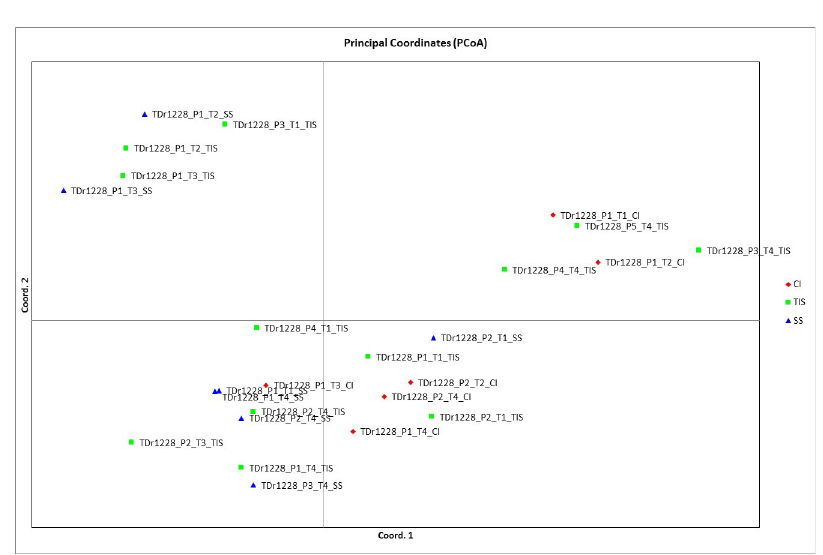
Fig 6. PCoA for Yam in field with Hpa II. CI: Complete Immersion, TIS: Temporary Immersion System, SS: Semi- Solid.